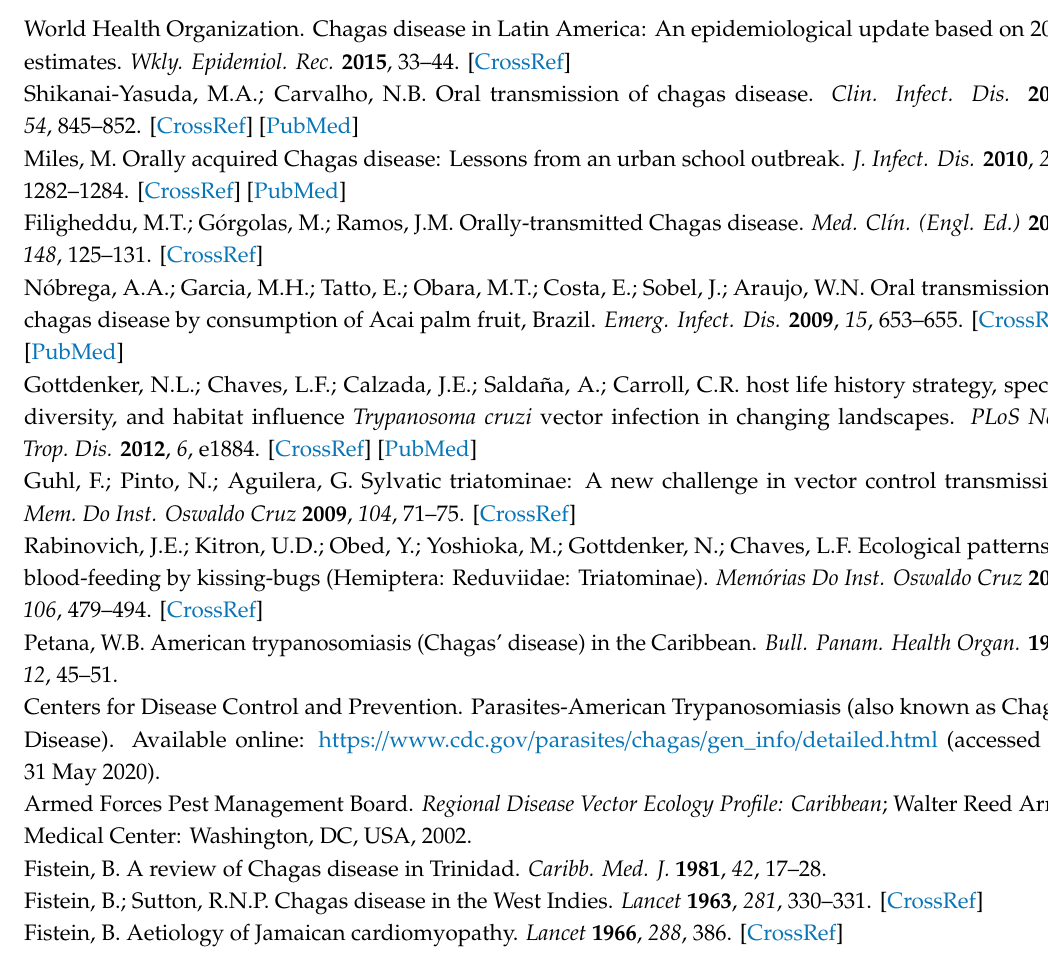
Figure S1: Chagas disease information pamphlet given out during this study. Table S1: Triatomine bug sample site details. File S1: Data for bugs collected, T. cruzi diagnosis, and blood meal host